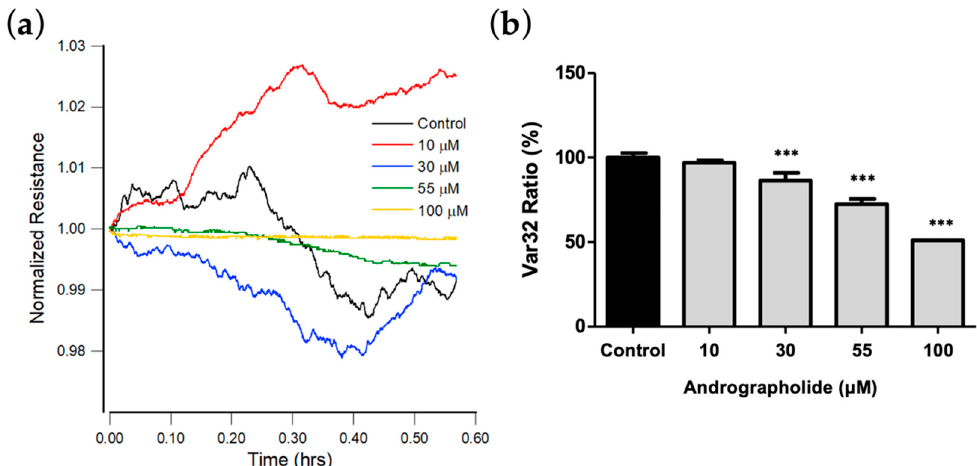
Figure 5. ( a ) Normalized resistance data recorded 24 h after the addition of medium containing andrographolide or medium alone to a confluent OEC-M1 layer to a final concentration of 10 µ M (red), 30 µ M (blue), 55 µ M (green), 100 µ M (yellow), and control (black). Each curve has data points at 1 s intervals. ( b ) Var32 analysis of OEC-M1 micromotion after exposure to andrographolide for 24 h at the indicated concentrations. Values are shown as means ± SEM. *** p < 0.001. Each value is expressed as a percentage of the control.